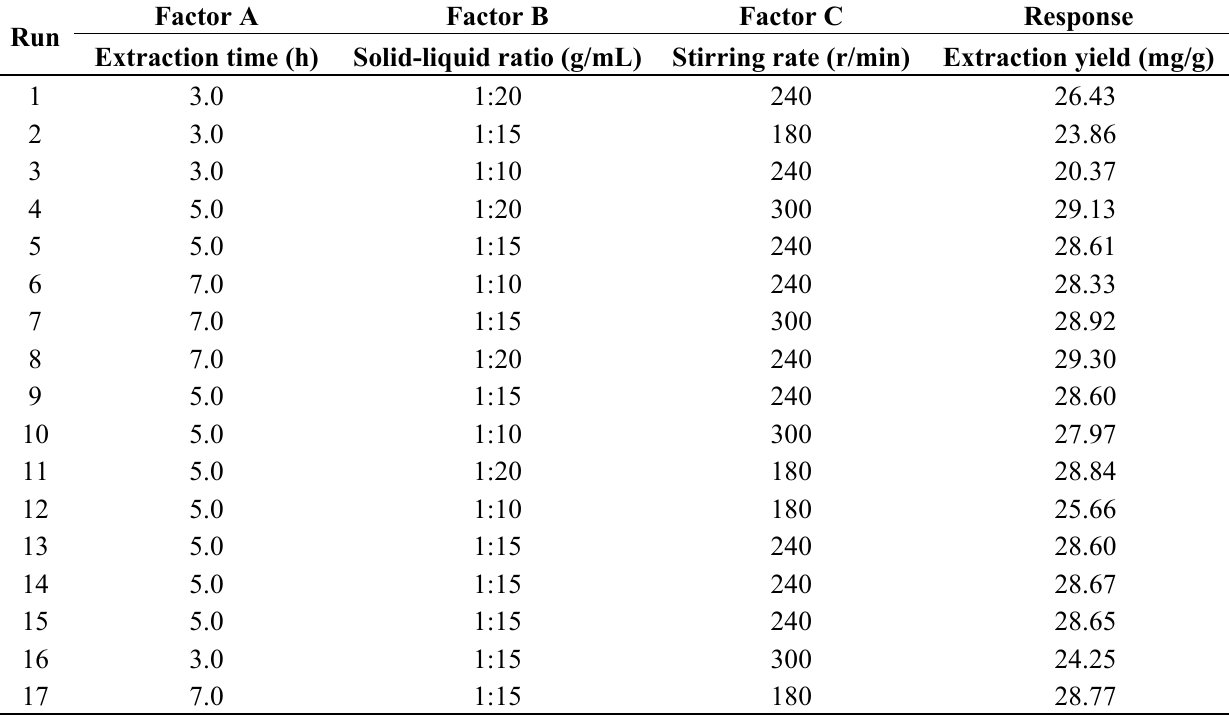
Table 1. Experimental design matrix to screen important variables for extraction yield of anthocyanins.